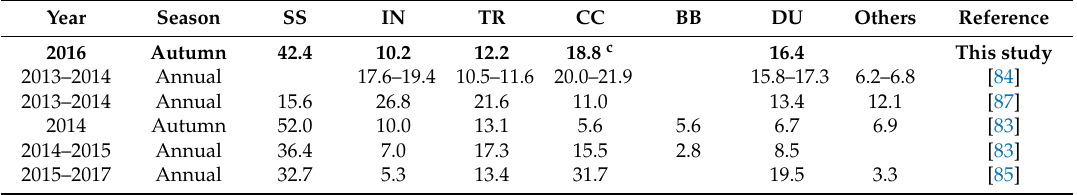
Table 4. Positive matrix factorization (PMF) results of PM 2.5 in Shijiazhuang obtained in previous